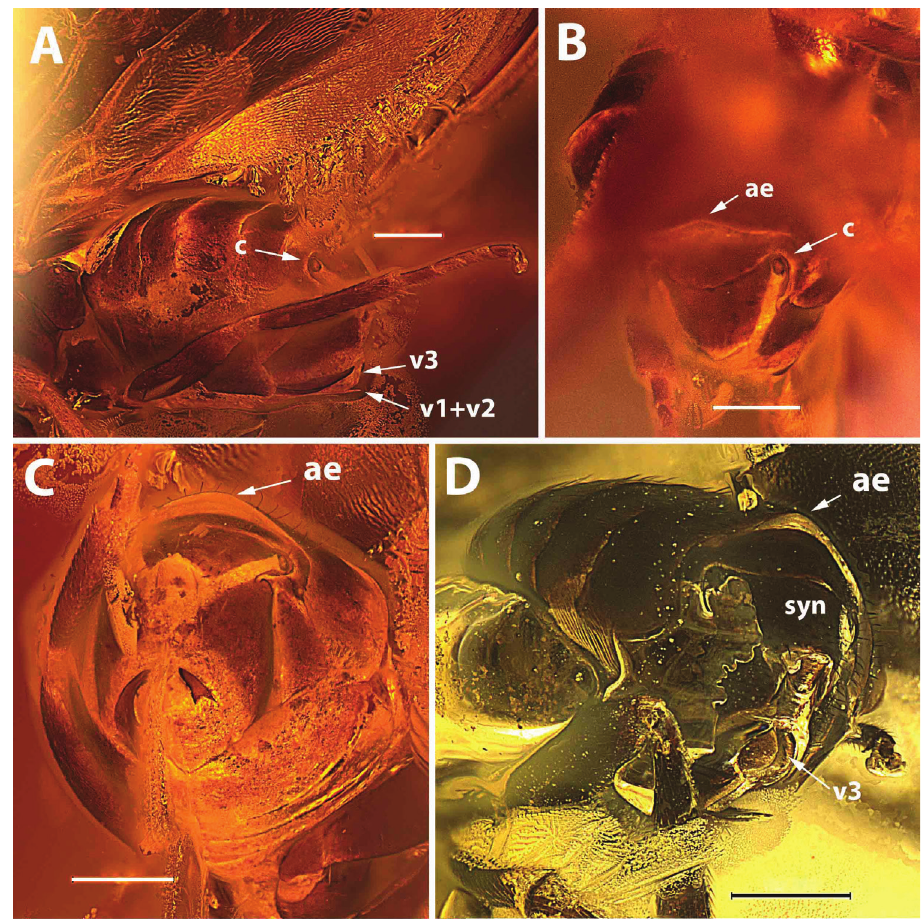
Figure 8. S. glaesaria , females, metasoma A–C holotype D Rovno specimen A lateral B dorsal C poster- oventral D posterolateral. (ae – arched elevation of Mt6, c – cercus, syn – syntergum, v1+v2 – ovipositor stylet, v3 – ovipositor sheath). Scale bars: 0.2